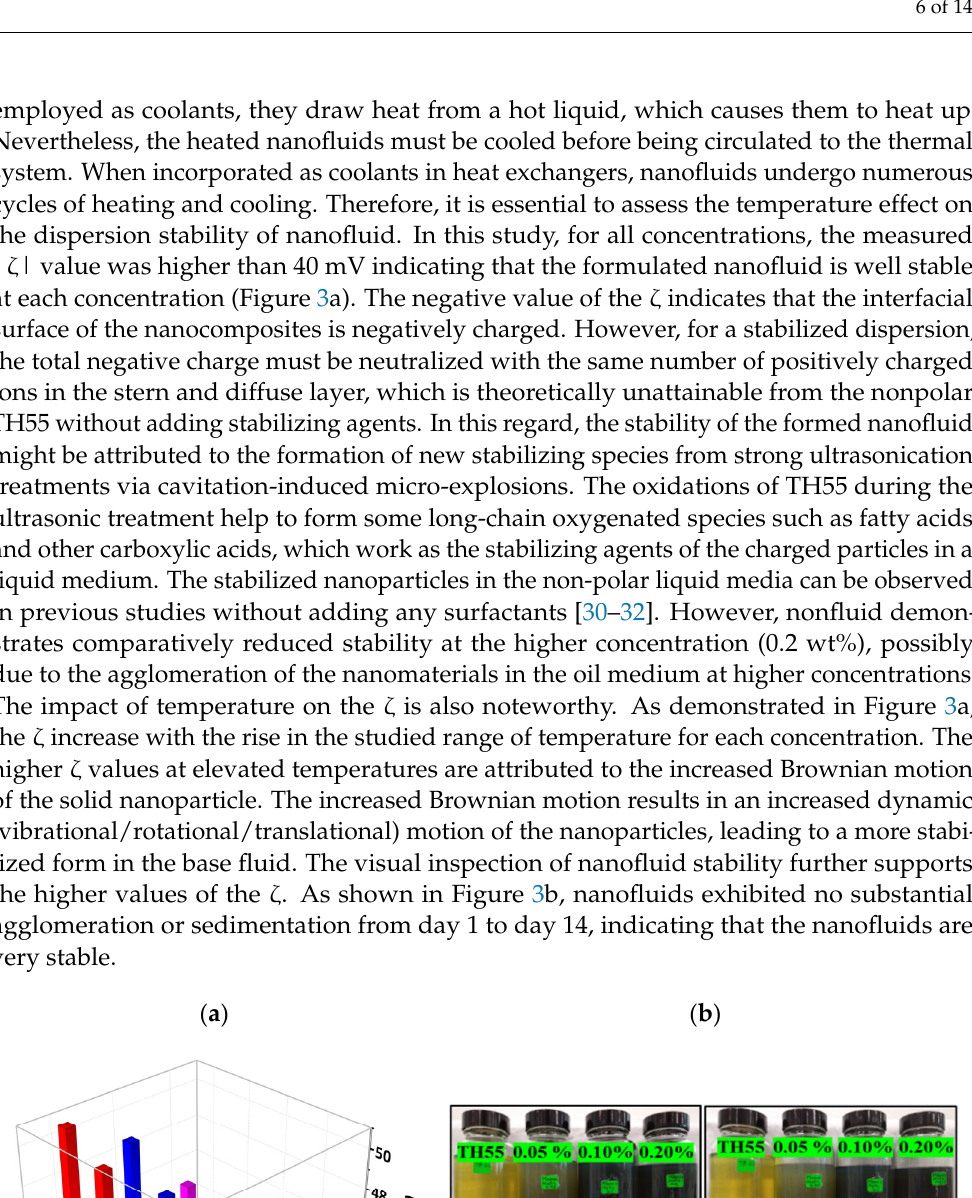
6 of 15 Figure 2. SEM of: ( a ) synthesized MXene at low magnification; ( b ) layered structure of MXene nanosheets at high magnification; ( c ) EDX analysis of the MXene; ( d ) SEM of MXene + Al 2 O 3 nano-